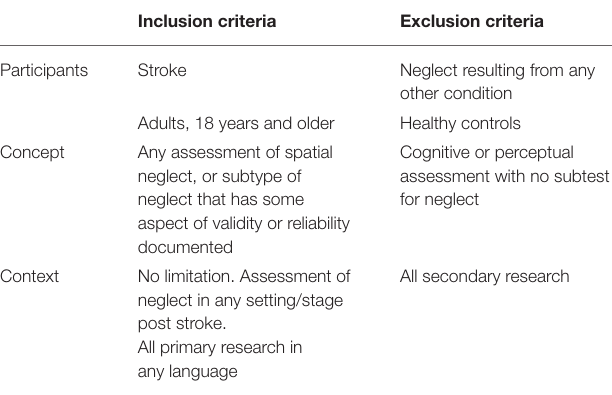
TABLE 1 | Study selection